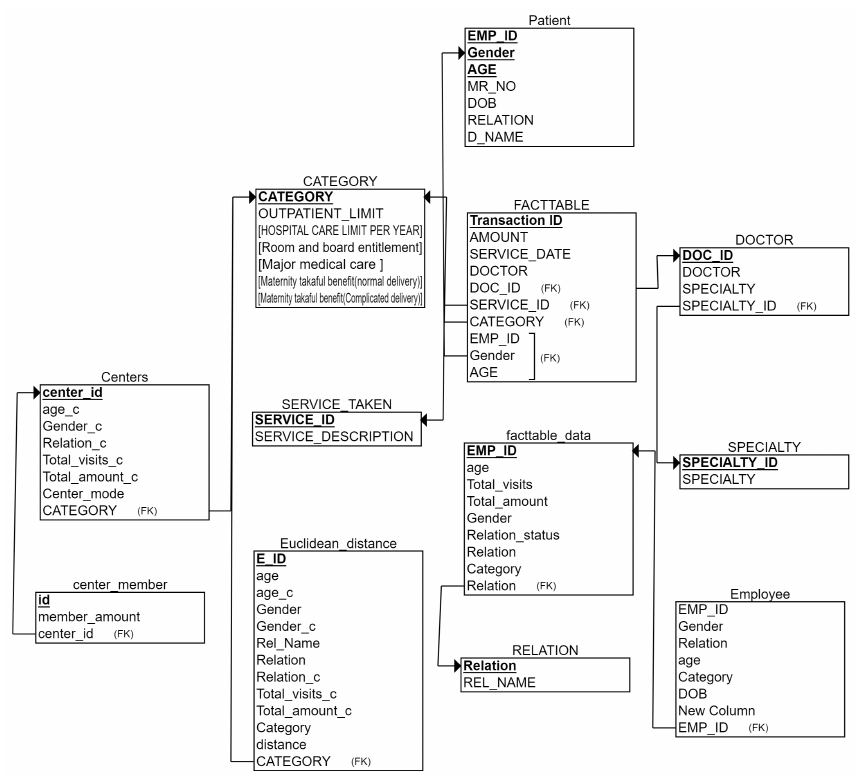
Figure 5. Relational database for medical benefit optimization